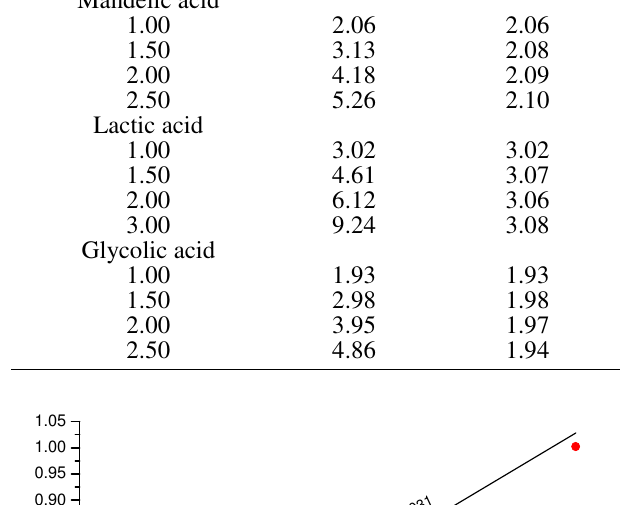
Table 7. First order values of the concentration of α -hydroxy acids in CTAB [H O ] = 2.00 x 10 -3 mol dm -3 , [ H 2 2 Temperature = 35 ± 0.2 0 C.